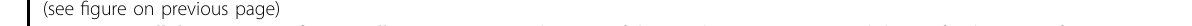
Fig. 1 Intercellular gene transfer via cell entrapment. a Schematic of the coculture experiment and the confocal images of RPE1-Venus-Parkin, MDA-MB-231-H2B-mCherry, and a recipient positive for both Venus-Parkin and H2B-mCherry signals. b Flow cytometric analysis of RPE1-Venus-Parkin, MDA-MB-231-H2B-mCherry, and recipient cells showing both Venus-Parkin and H2B-mCherry signals. c An integration site of MoLV reporter transgene in the genome of recipient cell RPE1mut231. d Effect of the donor to recipient cell ratio (Rd/r) on gene transfer frequency. The donor to recipient cell ratio (Rd/r) was calculated as the number of donor cells (Q3 + Q4) divided by the number of recipient cells (Q1 + Q2). e Flow cytometric analysis of gene transfer between RPE1-Venus-Parkin and MDA-MB-231-H2B-mCherry cells stably expressing mCherry-shRNA or a luciferase gene. The mCherry-shRNA, Rd/r = 0.76 ± 0.06; shRNA control, Rd/r = 0.53 ± 0.03. f Confocal images of the cell-in-cell structure formed by RPE1-Venus-Parkin and MDA-MB-231-H2Bm-Cherry. g Confocal live-cell imaging of cell entrapment between RPE1 and MDA-MB-231-H2B-mCherry/ CAAX-mCherry. The upper panel shows the engulfment of a donor cell by the recipient cell; the bottom panel shows the exit of a donor cell from the recipient cell. h Flow cytometric analysis of gene transfer between MDA-MB-231-H2B-mCherry and RPE1-Venus-Parkin with siRNA against luciferase, ROCK1 , ROCK2 , or ROCK1 plus ROCK2 . i Effect of ROCK kinase depletion on cell entrapment between MDA-MB-231-H2B-mCherry and RPE1-Venus- Parkin with siRNA against luciferase, ROCK1 , ROCK2 , or ROCK1 plus ROCK2 . j , k Effect of Latrunculin B on intercellular gene transfer and F-actin stability (Alexa Fluor ™ 594 Phalloidin). Data were means ± SD; statistical signi fi cance for e, h and i was assessed using the student ’ s t- test (**** P <